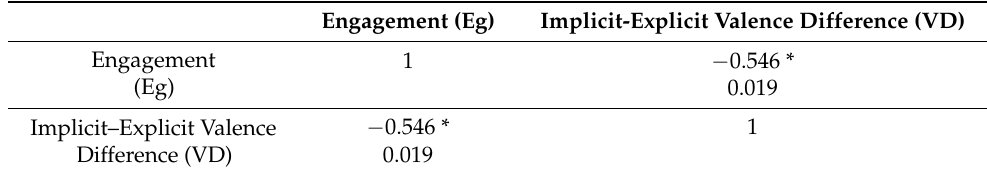
Table 6. Correlation between the variable Implicit–Explicit Valence Difference and Engagement.